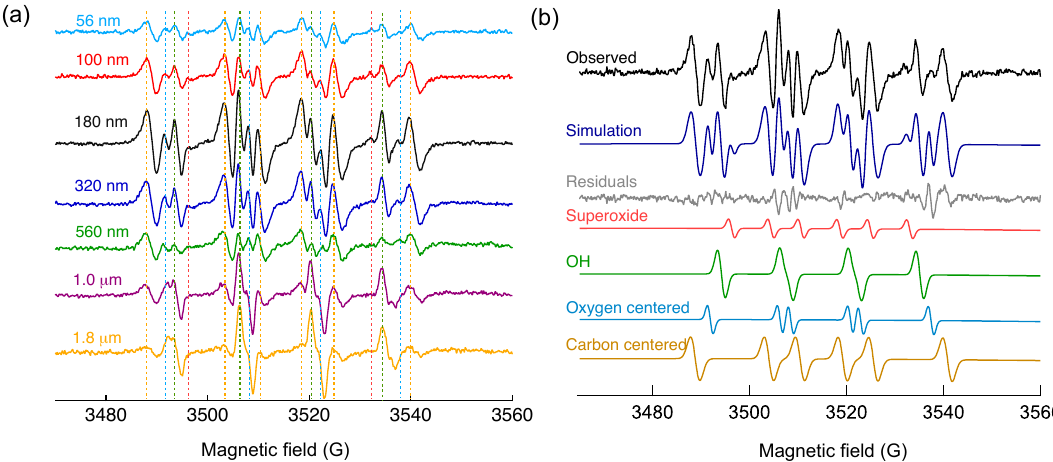
Figure 4. (a) Electron paramagnetic resonance (EPR) spectra of ambient aerosol impactor samples (Mainz, Germany; 26–27 June 2015) with lower cut-off diameters in the range of 56nm to 1.8µm extracted in water mixed with the spin-trapping agent BMPO. Dashed lines indicate the position of each peak for different types of trapped radicals of O − (red), OH (green), carbon-centered (orange) and oxygen-centered 2 organic radicals (light blue). (b) Simulation of the EPR spectrum of the atmospheric aerosol impactor sample with particle diameters in the range of 180–320nm (lower to upper cut-off) by deconvolution into O − , OH, O-centered and C-centered organic radicals (Blue is synthesis, 2 grey is